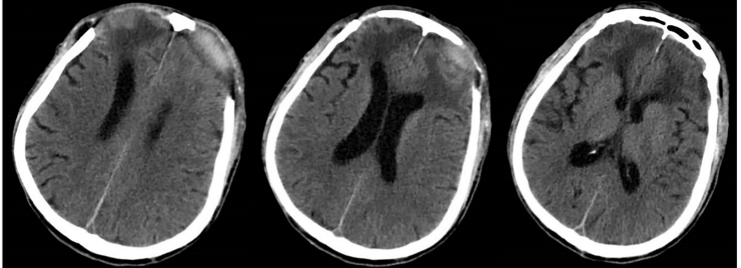
Figure 4. The craniocerebral CT examination on the eighteenth postoperative day, after bilateral frontal decompressive craniectomy. The bilateral frontal lobe brain tissue was slightly swollen, and the edema was better than before. Table 1. The result of electromyography examination.